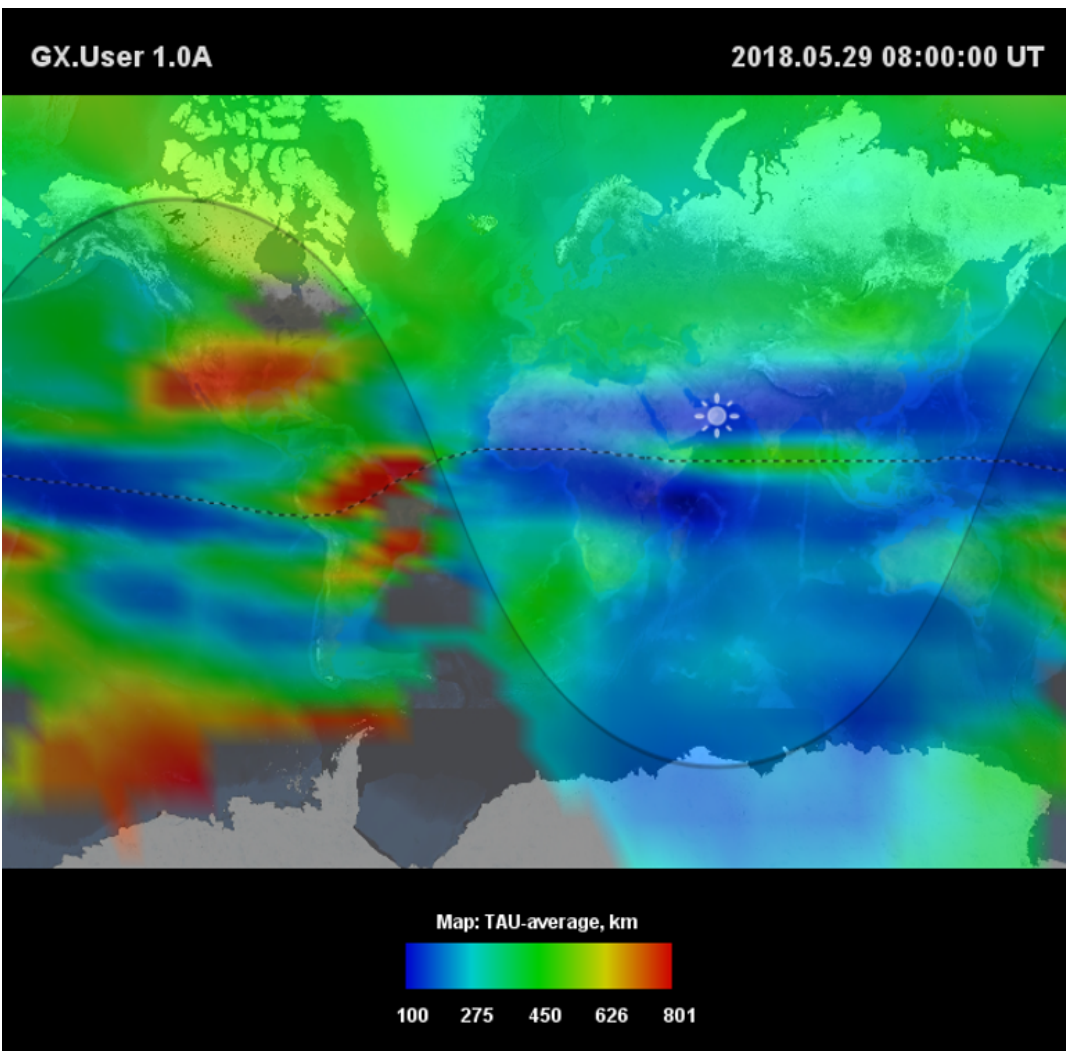
Figure 7. Resulting slab thickness ( τ ) for the same time as in Figure 6 shows significant decrease in value in the areas with high electron